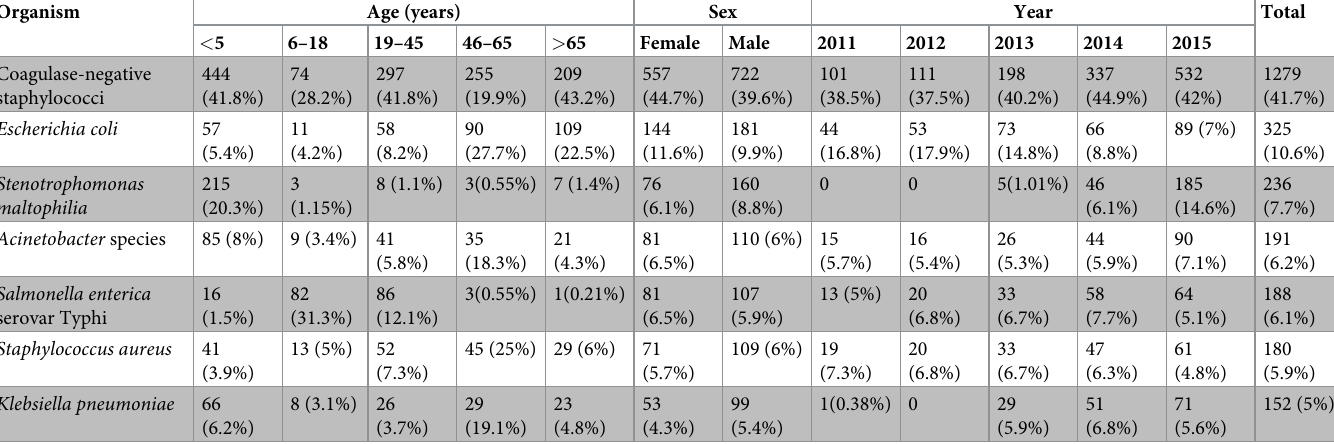
Data are n (% isolates in a column). Bacterial species with relative frequency above 5% are shown.in the